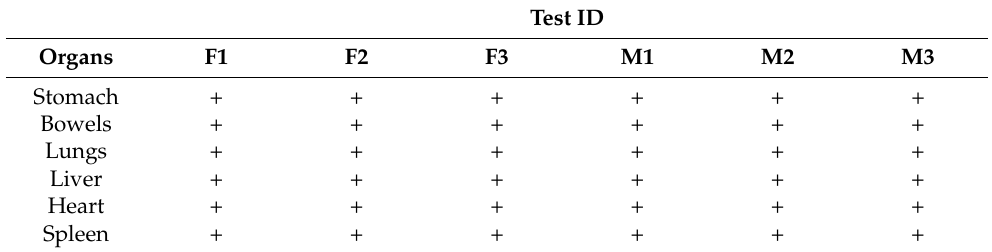
Table 10. Macroscopical evaluation of internal organs after acute inhalation toxicity testing.